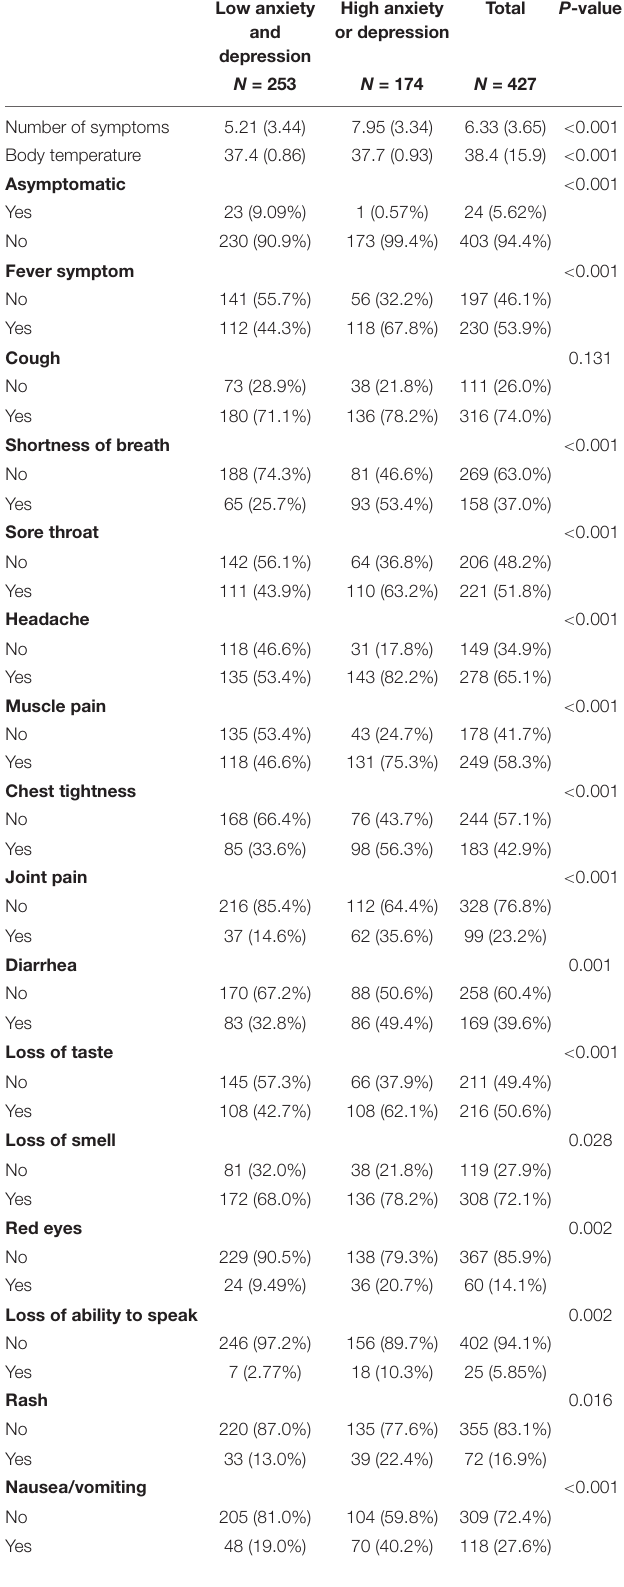
TABLE 2 | Symptoms of coronavirus disease 2019 (COVID-19) by anxiety and depression status.